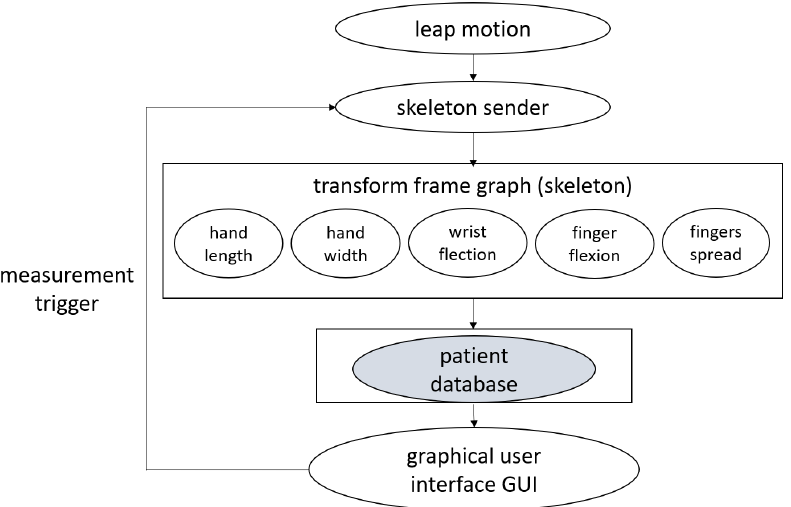
Figure 2. Leap Motion data acquisition and processing